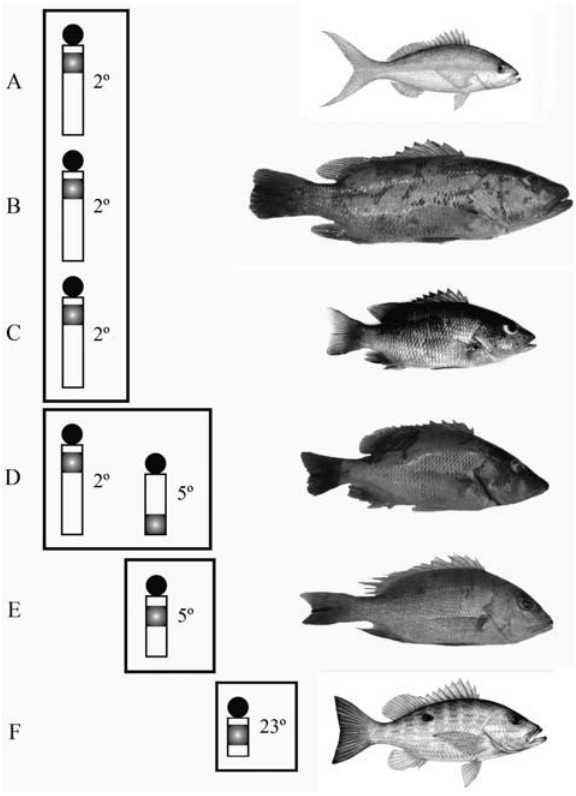
Figure 7 - Representative picture of the number and location of ribosomal sites on NOR-bearing chromosomes of O. chrysurus (A), L. cyanopterus (B), L. alexandrei (C), L. jocu (D), L. analis (E), and L. synagris